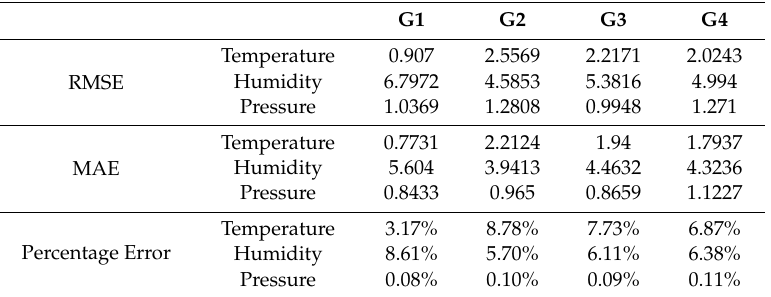
Table 9. Forecast results of di ff erent input data formats with the MLP